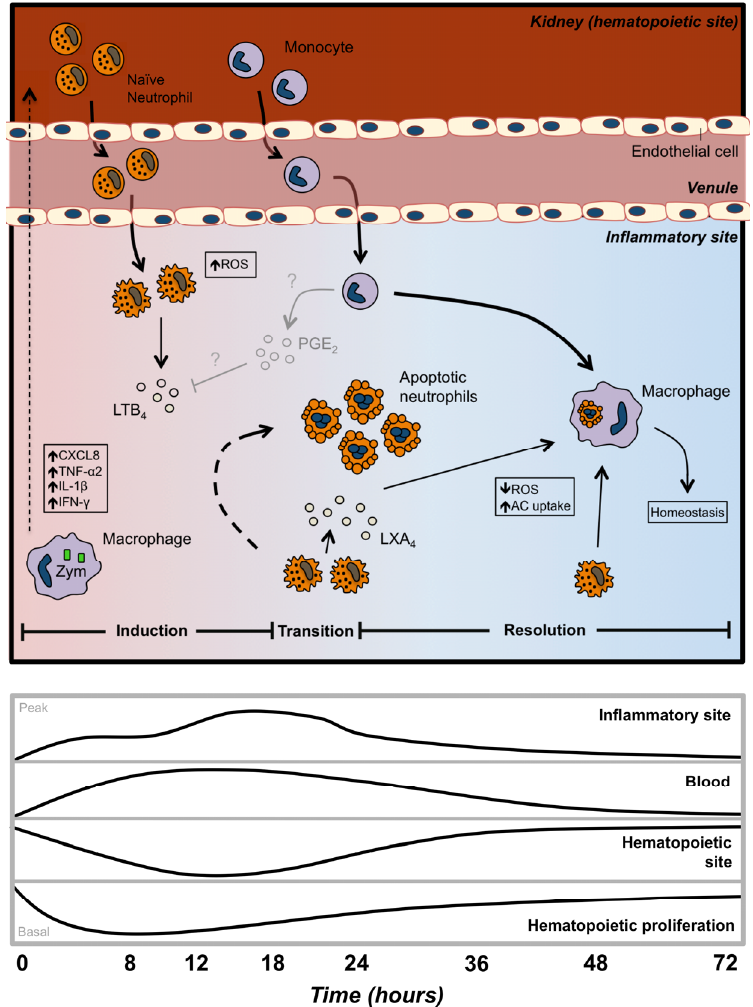
Figure 1. Contributions of neutrophils to the induction, regulation, and resolution of the acute inflammatory response in teleost fish. Peritoneal injection of zymosan results in the release of proinflammatory cytokines, such as CXCL8, TNF- α , IL-1 β , and IFN- γ , and chemoattractants like CXCL8 and LTB 4 , inducing the infiltration of neutrophils and other leukocytes. Inflammatory neutrophils enter the site of inflammation and are subsequently activated by the inflammatory milieu, resulting in increased ROS production and the release of more LTB (pro-inflammatory lipid mediator). As inflammation progresses, a 4 transition from pro-inflammatory to pro-resolution begins to occur (18–24 hpi). Neutrophils then alter their production of lipid mediators to increase the release of LXA followed by 4 , an entry into apoptotic cascades, peaking at 24 hpi. We hypothesize that this switch from LTB4 to LXA4 is mediated, at least in part, by the release of PGE from local cells (grayed 2 out in model with question marks). The local inflammatory milieu slowly becomes pro-resolving as macrophages are stimulated by LXA , decreasing their production of ROS 4 and increasing their uptake of apoptotic neutrophils. This progression eventually leads to the return to homeostasis by 72 hpi. The relationship between neutrophil production within the kidney hematopoietic tissue, their migration through the blood, and infiltration into the challenge site highlight unique features of the teleost